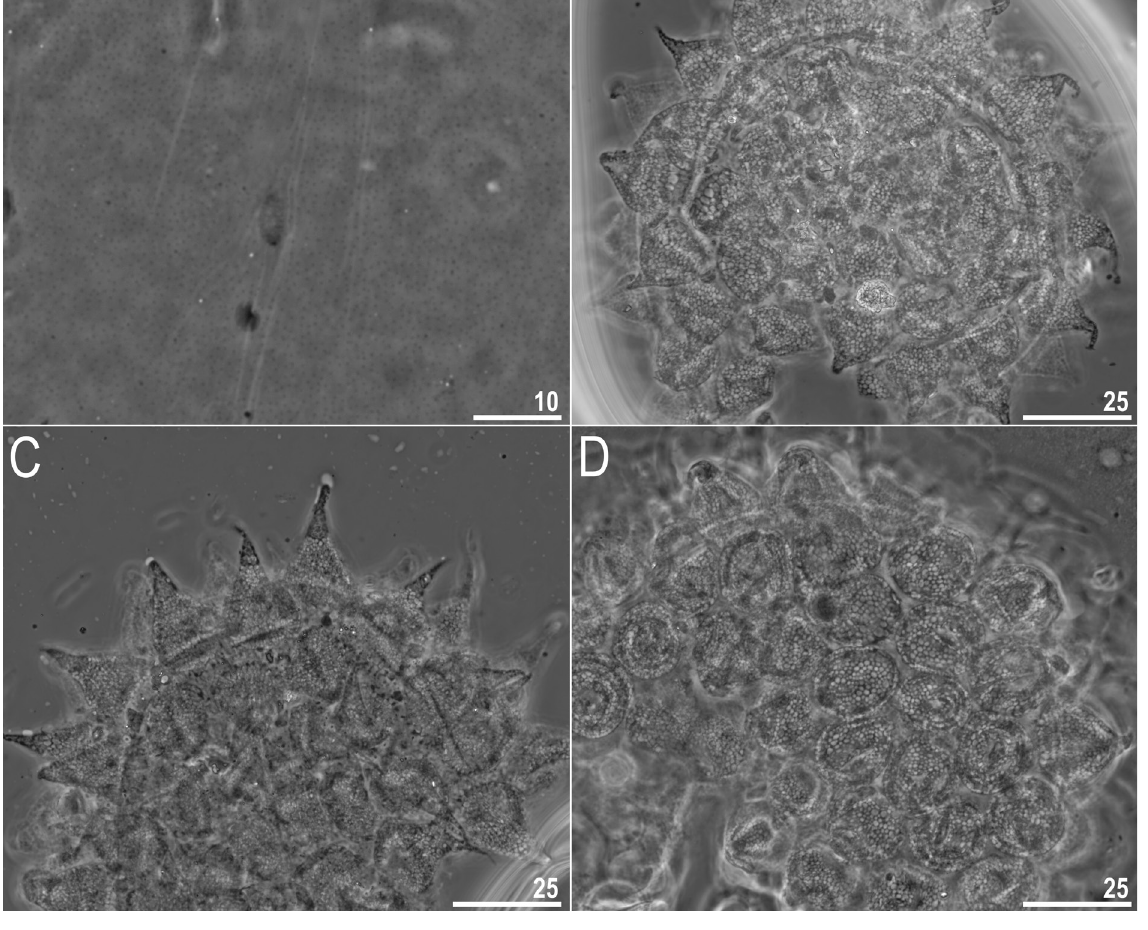
Fig. 23. Tenuibiotus cf. voronkovi (Tumanov, 2007) from the Edgeøya population, body cuticle and eggs seen in PCM. A . Uniformly distributed granulation on the dorsal side of the body at the level between leg pairs II and III. B – D . Three different eggs under 1000× magnification. Scale bars in